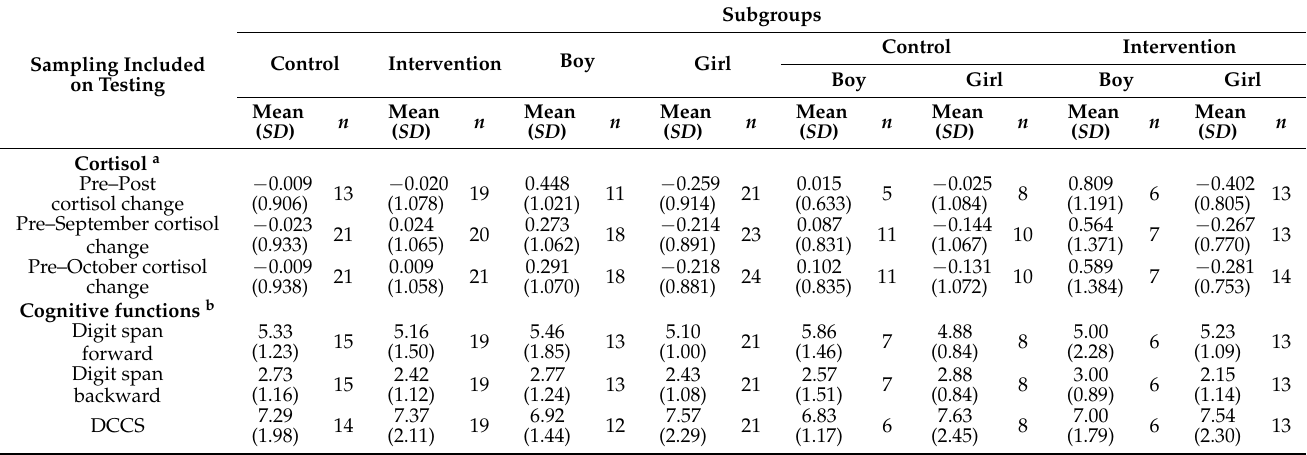
Table 2. Baseline (pre-test) values in control and intervention group for each outcome included in post-test or follow-up measures.